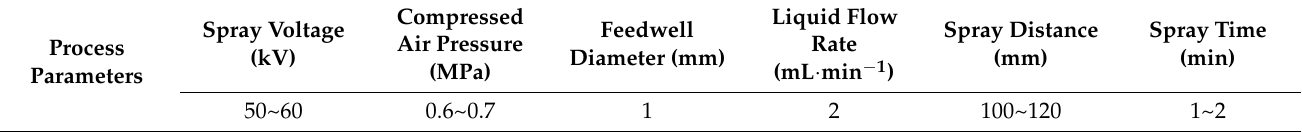
Table 2. Process parameters of the sandblasting